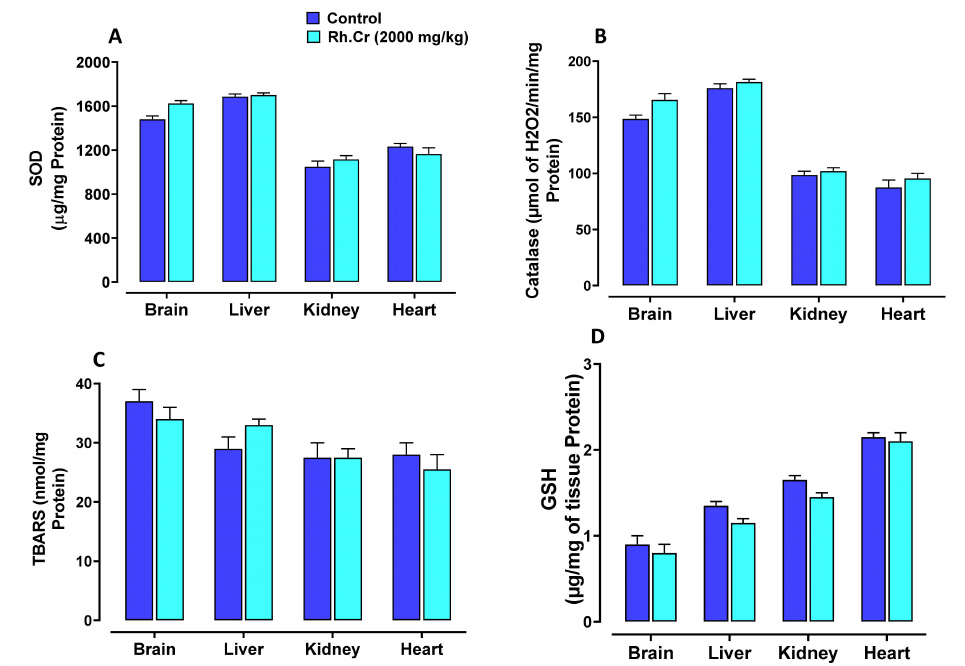
Figure 13. Effect of Rumex hastatus crude extract (Rh.Cr) against ( A ) superoxide dismutase (SOD), ( B ) catalase, ( C ) lipid peroxidation (LPO) and ( D ) reduced glutathione (GSH) in different tissues of